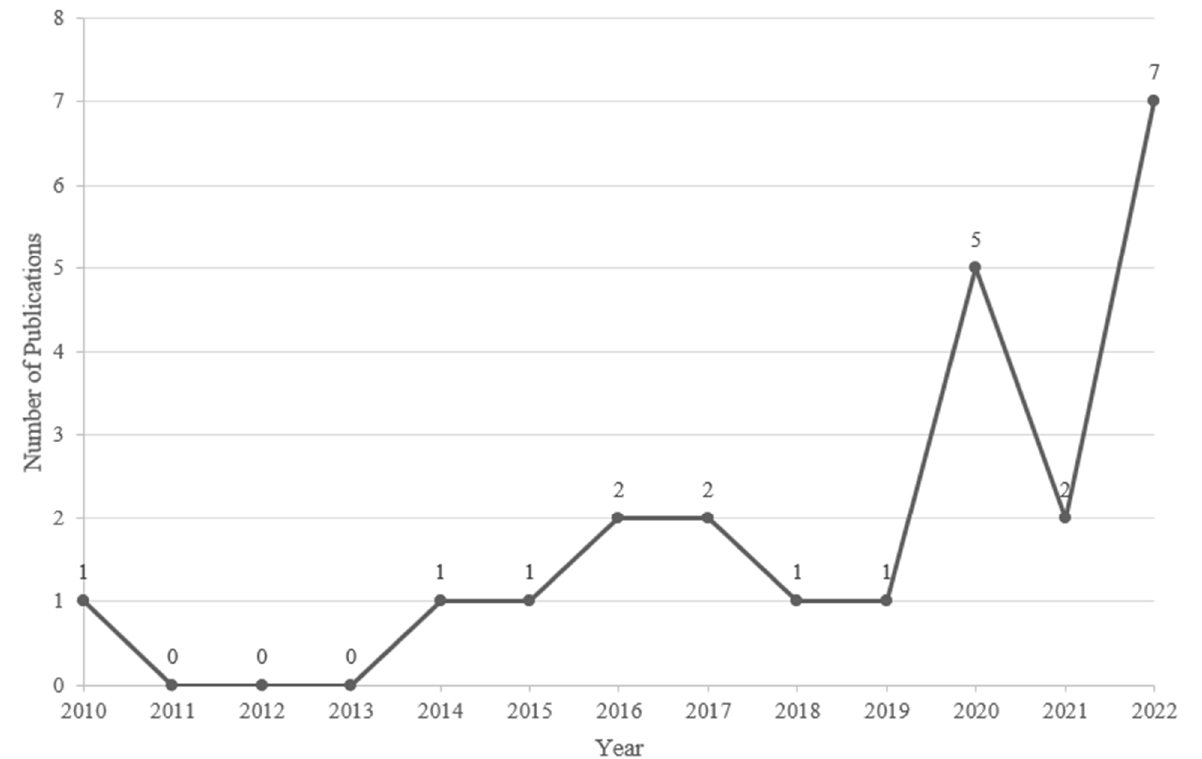
Figure 2. Number of HL publications included in the review across years.